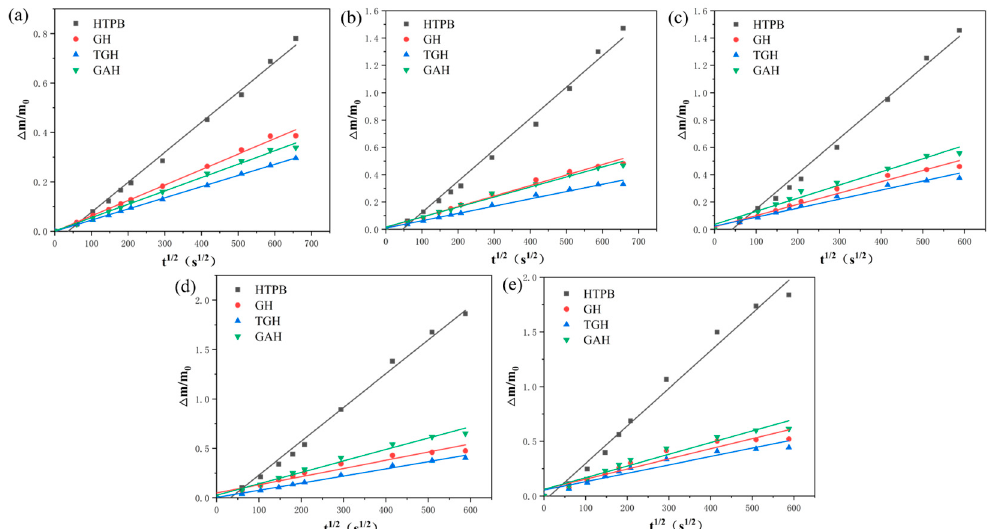
Figure 9. Linear fit of the DOS migration coefficients in the different liners using the dipping method. ( a ) Room temperature; ( b ) 40 °C; ( c ) 50 °C; ( d ) 60 °C; ( e ) 70 °C.